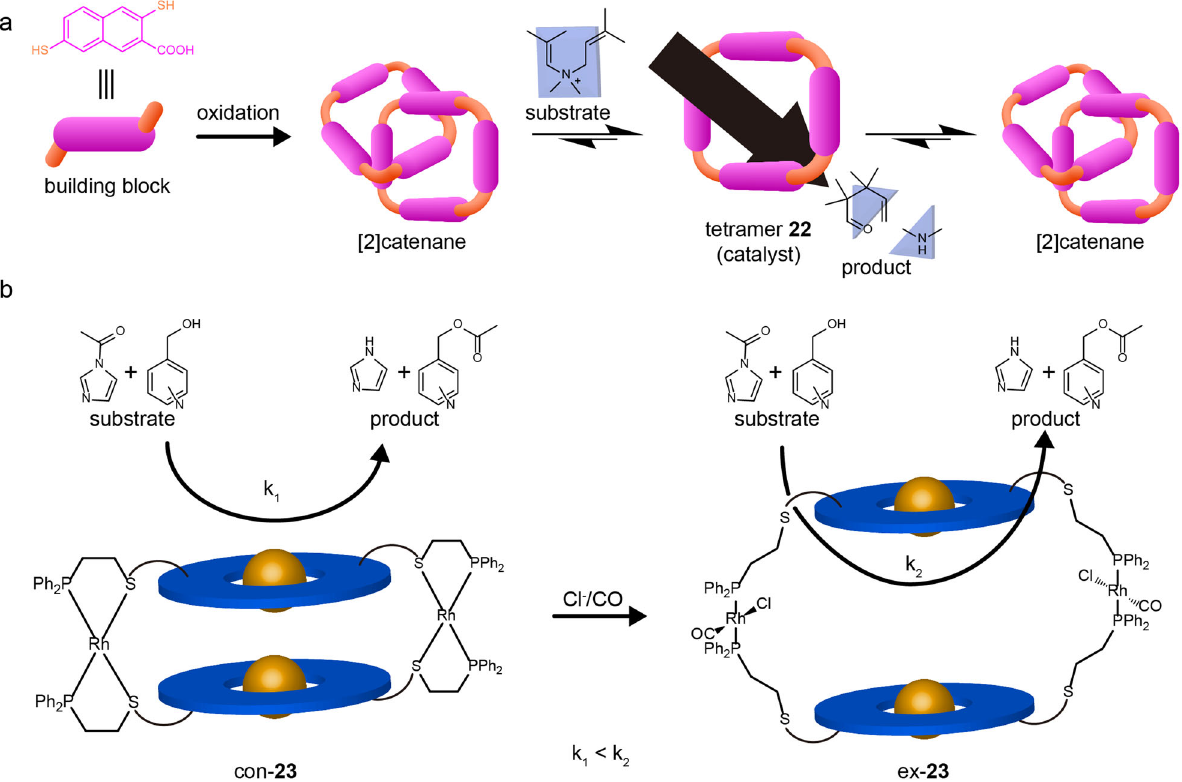
Fig. 7 SRMs for smart catalyst. a oxidation of dithiol building block and the dynamic catalyzed reaction between cation substrate and catalyst tetrameric macrocycle 22 72 . b the catalytic process of acyl transfer reactions by a closed macrocycle con- 23 vs open macrocycle ex- 23 , the latter can bind the substrates within the bigger cavity renders the higher rate of the reaction 73